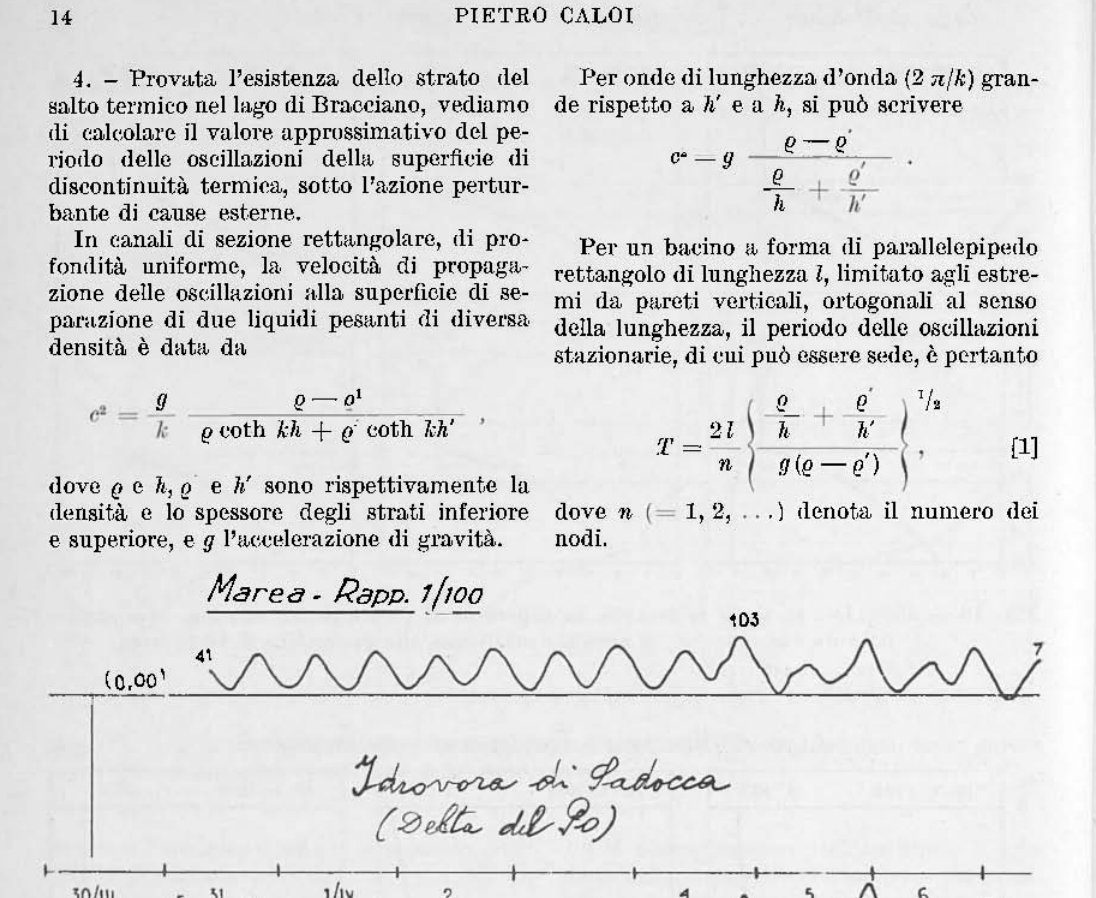
Fig. 21. - .\-larea solida (deviazione verticale apparente) registrata a Sarloeea dalla comp. E\Y (leI elinografo ivi fUlizionante, in eorrispondenza [lella marea liquida. sopra ripor. tata nel rapporto